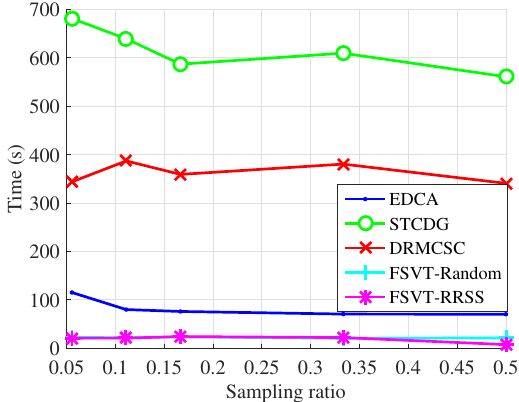
Figure 8. Running time over sampling ratio for the temperature from Data-Sensing Lab.